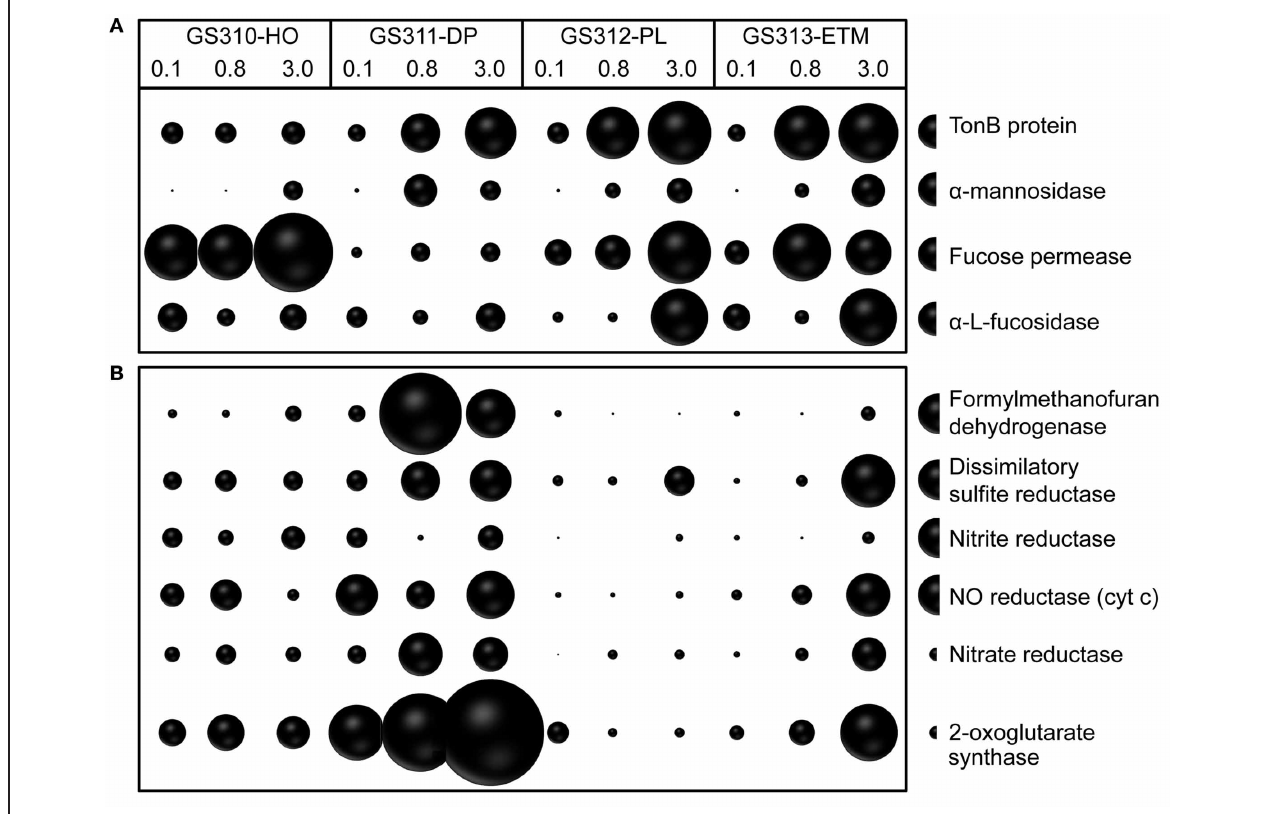
FIGURE 10 | (A) Functional gene categories related to phytoplankton bloom utilization and dissolved organic matter assimilation, including TonB protein (COG0810), α -mannosidase (EC:3.2.1.24), fucose permease (COG0738), and α -L-fucosidase (EC:3.2.1.51). (B) Enrichment of genes involved in anaerobic pathways in ETM particles and the deep water metagenomes: formylmethanofuran dehydrogenase (COG1029, 1153, and 1229); dissimilatory sulfite reductase (desulfoviridin, COG2221 and 2920); nitrite reductase (nirS, nirK, EC:1.7.2.1); nitric oxide reductase (cyt c) (norB, norZ,